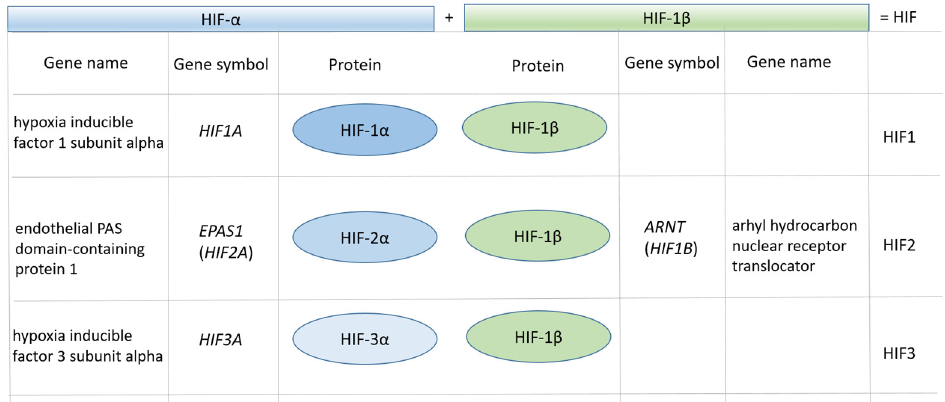
Figure 1. Terminology of the HIF gene family.